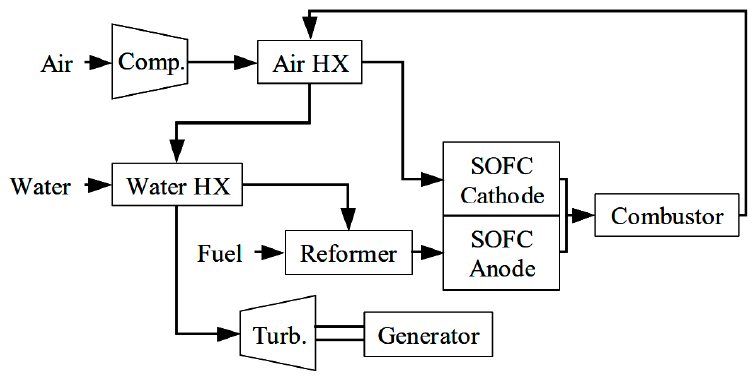
Figure 6. NASA’s NPSS SOFC/GT hybrid system architecture [12].